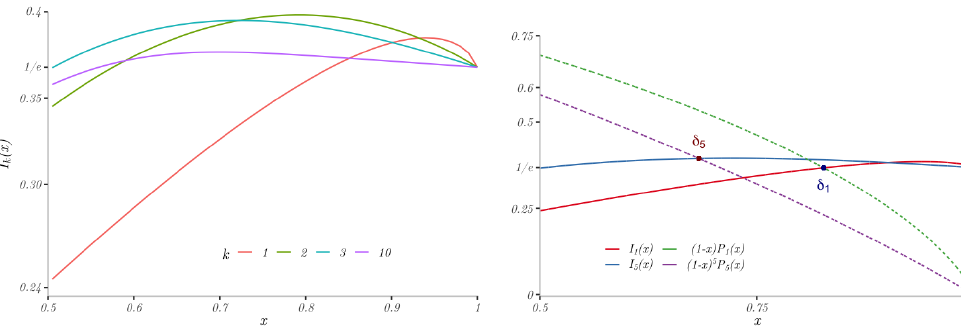
Figure 6. Information bounds on the optimal strategy I k ( x ) .